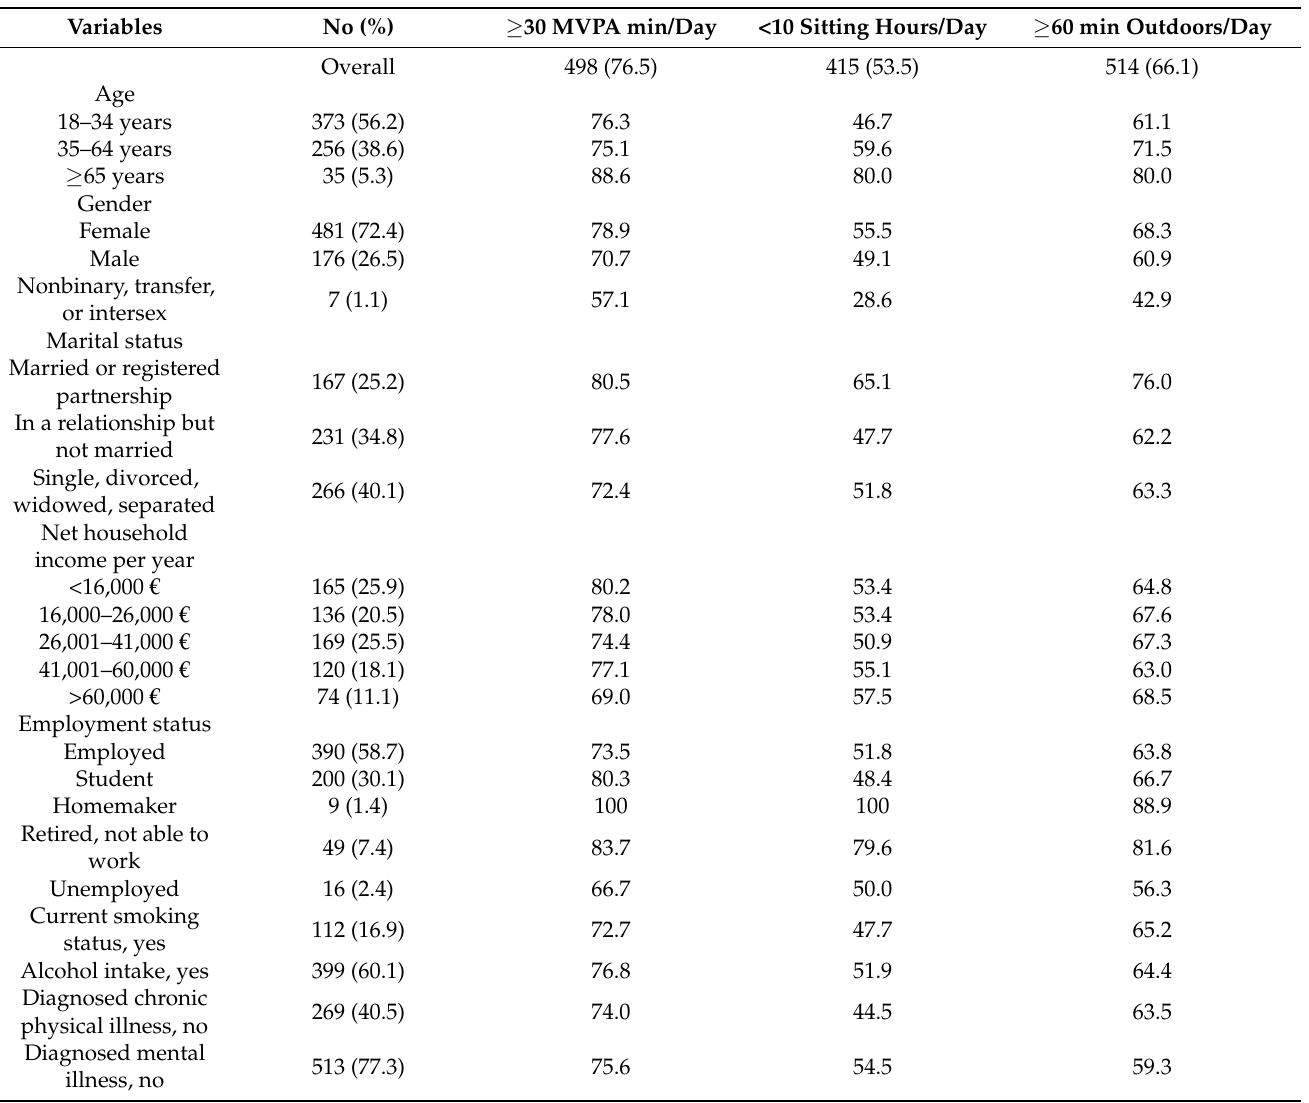
Table 1. Participants’ characteristics.